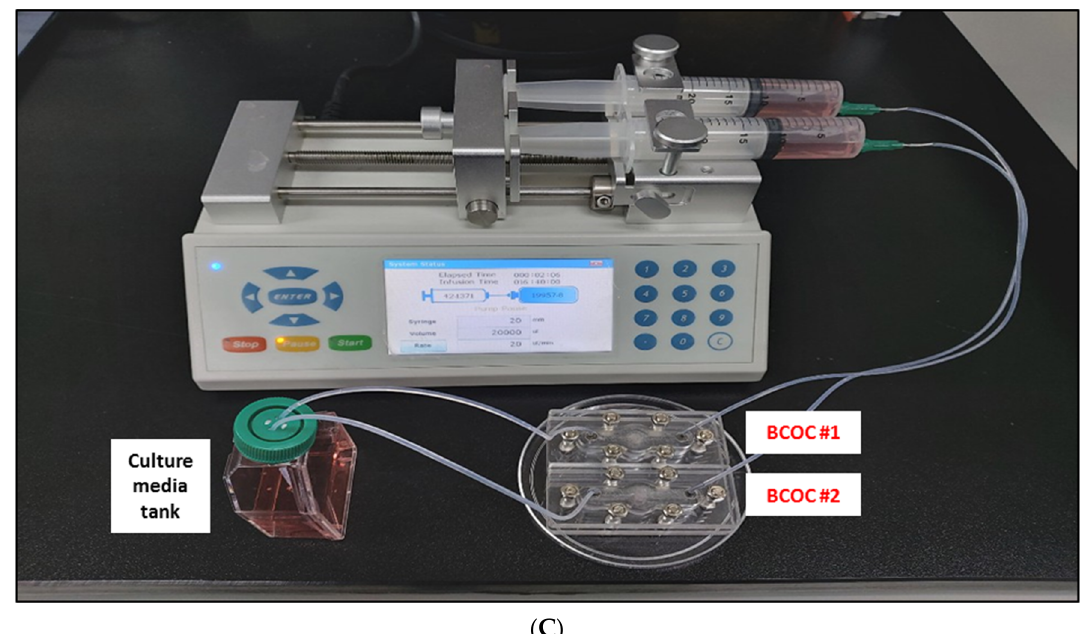
Figure 7. The concept of bladder cancer-on-a-chip . ( A ) The process to make the bioprinted cell block using a 3D bioprinter; ( B ) schematic illustration of the whole structure of the device; ( C ) the microfluidic device connected to the perfusion equipment.